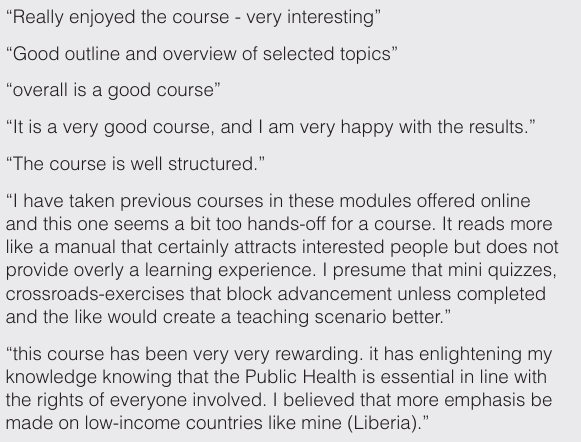
Number (% of those with